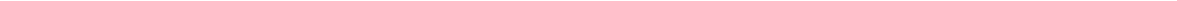
Fig. 6 FBXO32 expression correlates with tumor aggressiveness. a Bar plot showing the frequencies of mutations, deletions, ampli fi cations and multiple alterations in well-characterized transcriptomes and genomic datasets of different tumors of various origins available from CBioPortal. The x-axis shows various types of tumors, and the y-axis represents the percentage of tumors with a speci fi c defect. b , c Box plots showing expression level of FBXO32 in normal vs tumor samples in two well-characterized clinical tumor datasets for breast ( b ) and pancreas ( c ) origin. Box plots represent the 25th to 75th quartiles with the bold horizontal line representing the median value. d , e A Kaplan-Meier analysis was performed for the Breast tumor datasets. Survival curves showing decreased relapse free survival ( d ) and decreased metastasis free survival ( e ), which was signi fi cantly correlated with higher FBXO32 expression. f , g Box plots showing levels of key EMT markers expression in the clinical breast tumor databases used in Fig. 5d, e, respectively, and split based on expression of FBXO32. For all such analyses, here and later, we considered the fi rst and forth quartile of patient samples ordered based on the median expression of FBXO32. The best probe was considered for analysis, if provided by the manufacturers. Box plots represent the 25th to 75th quartiles with the bold horizontal line representing the median value. h , i Gene set enrichment analysis showing correlation between genes downregulated upon FBXO32 depletion and the genes associated to the speci fi ed GO terms, as a function of fold change between expression levels of these genes in tumors with high FBXO32 and low FBXO32 expression in the characterized tumor data sets in Fig. 5d, e, respectively. P value for fold change, Enrichment score (ES), Normalized Enrichment Score (NES) and FDR q -value were provided in the fi gure j The levels of FBXO32 mRNA in epithelial ( n = 256) and mesenchymal ( n = 249) cancer cell lines are shown as the FPKM derived from the publically available RNA-seq data (C Klijn et al, 2015) and the results were plotted on the y -axis. k The levels of FBXO32 mRNA in non-invasive (DCIS) ( n = 20) and invasive tumor samples ( n = 20) were measured relative to TBP via RT-PCR, and the results were plotted on the y-axis. * p < 0.05, Student ’ s t test. See also Supplementary Figs. 9 and